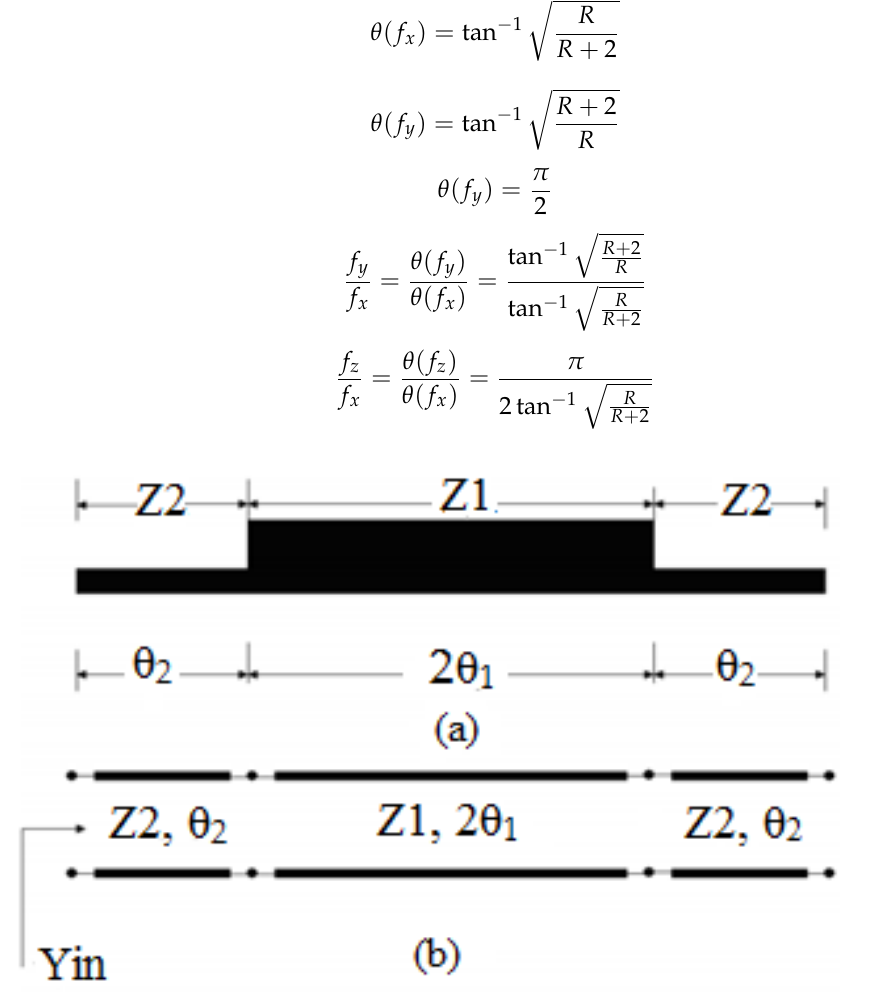
Figure 3. ( a ) Multimode resonator with step impedance configuration. ( b ) Equivalent configuration of the multimode resonator.